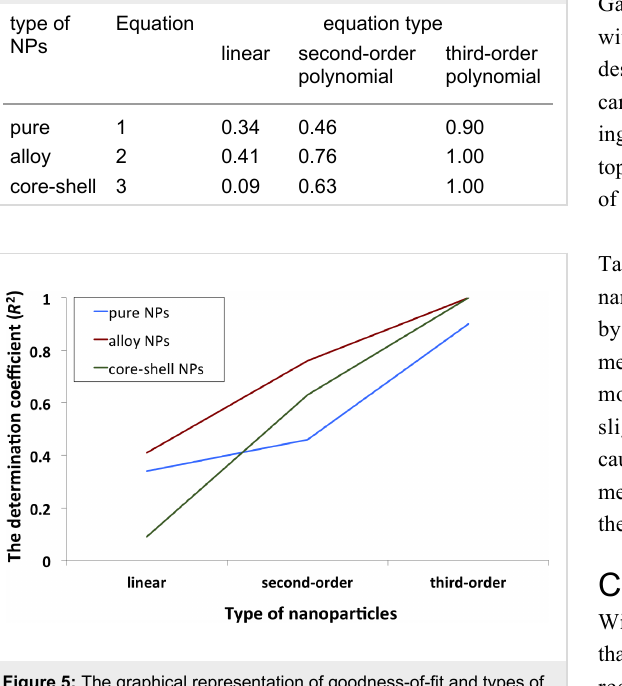
Figure 5: The graphical representation of goodness-of-fit and types of dependencies for the developed models.